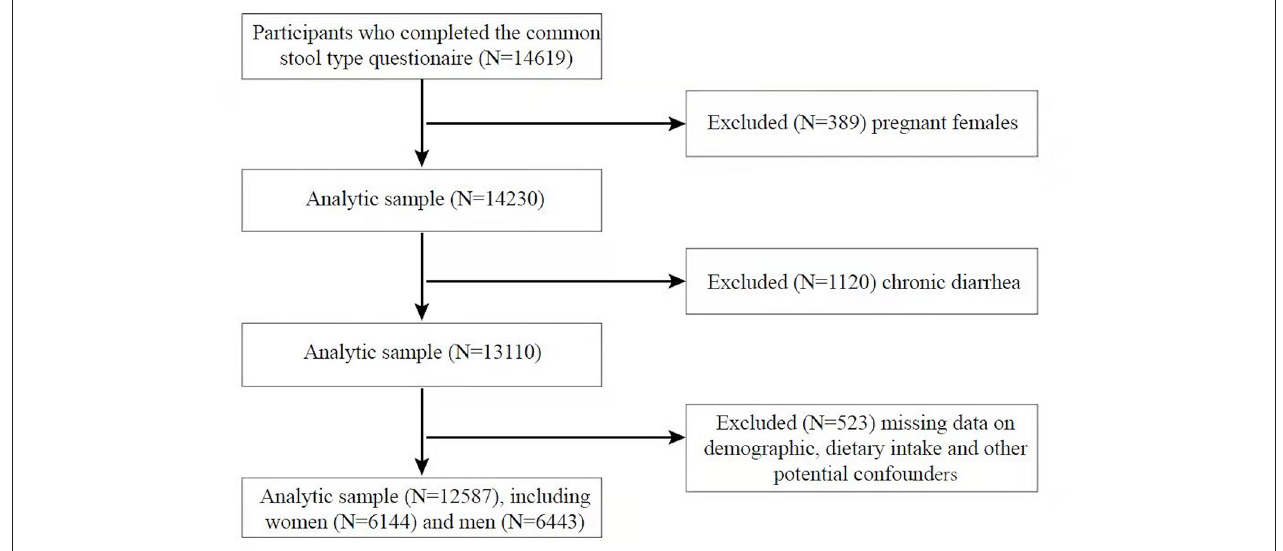
FIGURE 1 | Flowchart of the selection